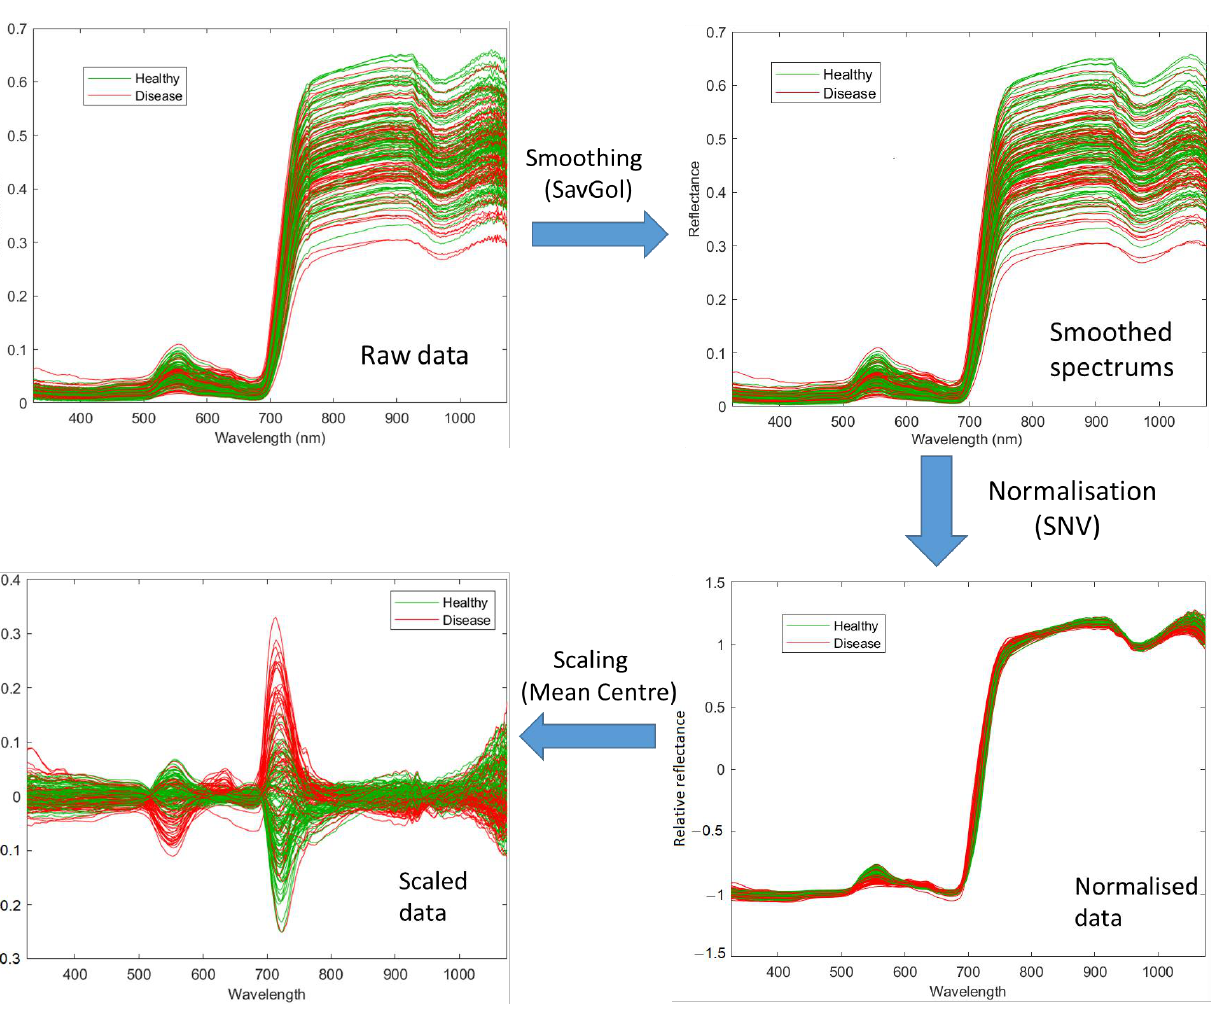
Figure 2. Spectral data pre-processing steps for Pinot Noir at the February 2021 timepoint. The raw spectral data is smoothed using the SavGol algorithm with seven bandwidths, then normalised using the standard normal variate algorithm and, lastly, scaled using the Mean Centring algorithm for 750 bands.